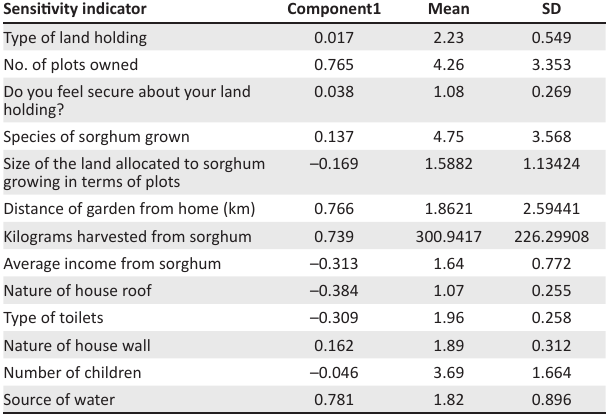
TABLE 3: Factor loadings for sensitivity. Sensitivity indicator